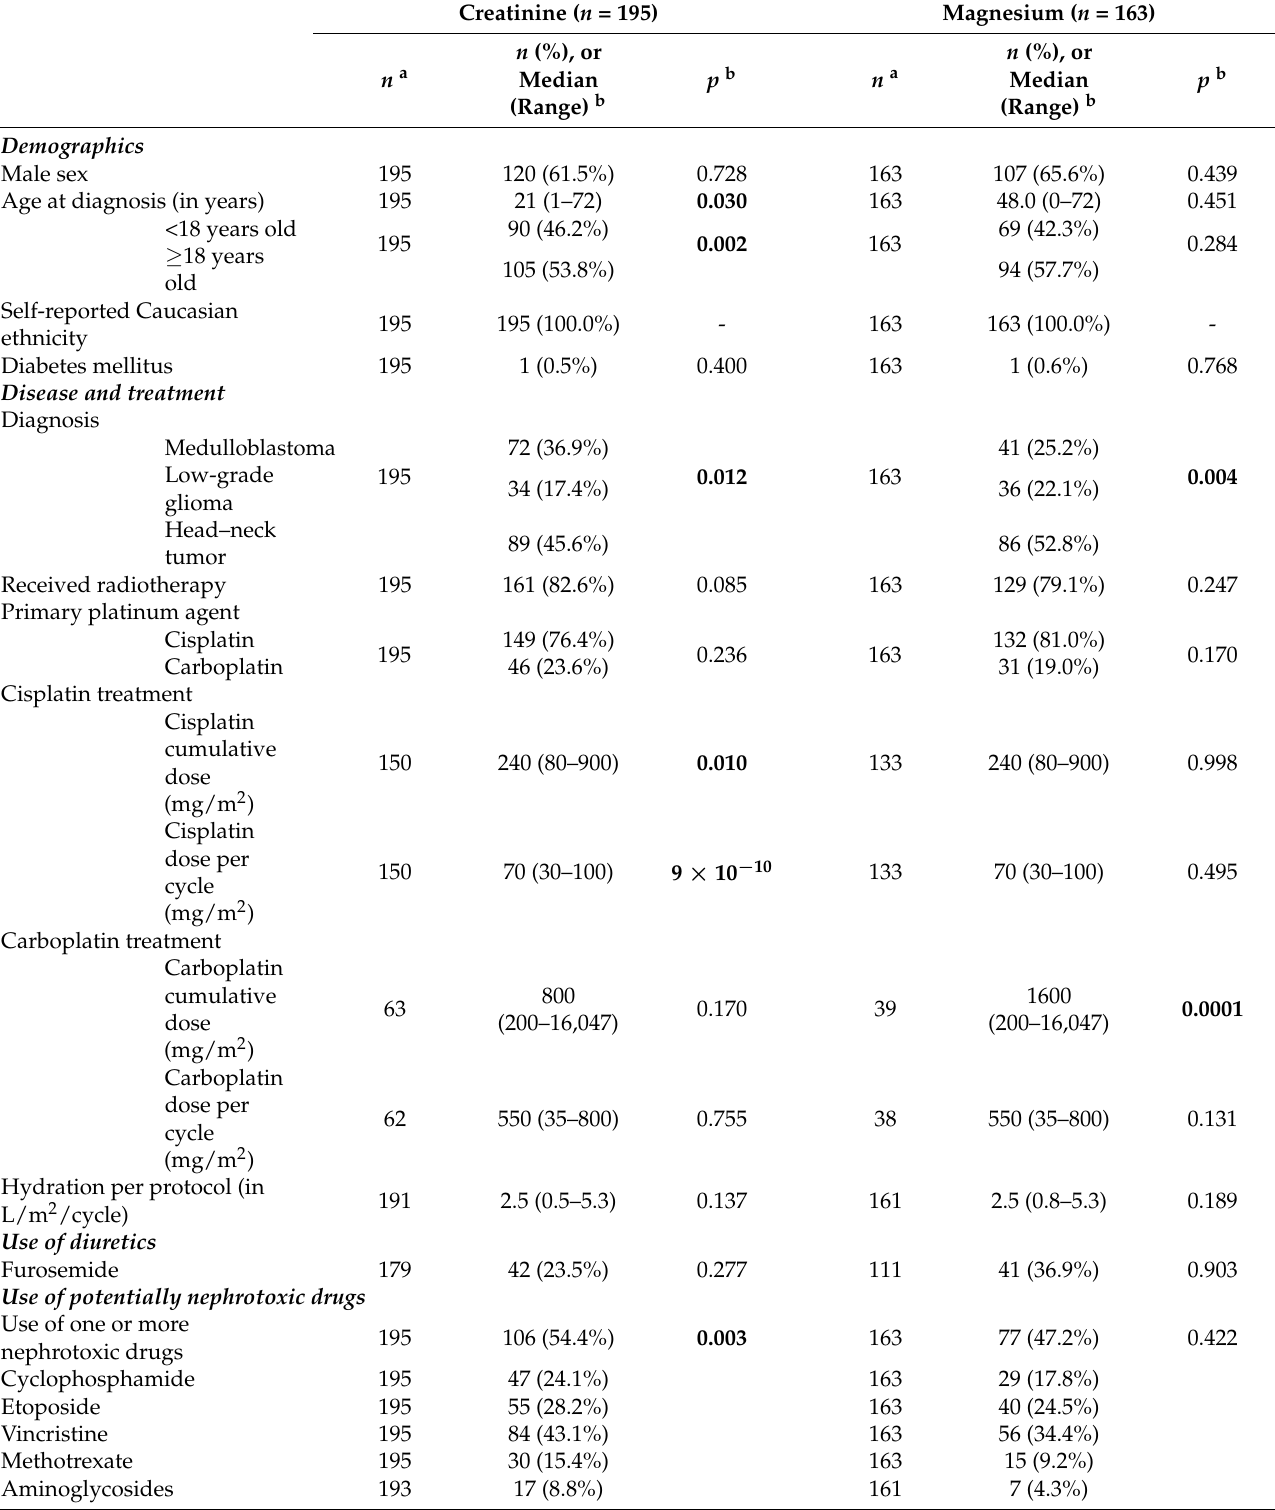
Table 1. Characteristics of patient